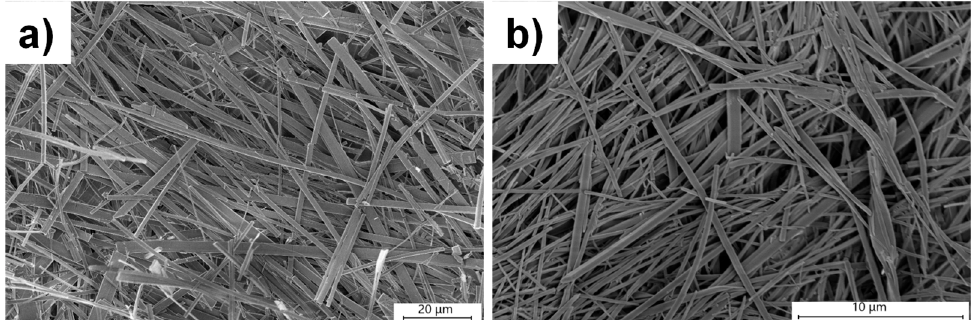
Figure 10. SEM images of xerogels obtained with L 3 in the presence of 1.0 equivalence of CdCl 2 in ( a ) 0.7 wt% in pure water and ( b ) 2.0 wt/v% in DMSO/water (1:1, v / v ). We analyzed the powder X-ray patterns of the dried gels at 2.0 wt% and 0.7 wt% of L 3 hydrogels in the presence of 1.0 equivalence of CdCl 2 , respectively. Analysis of the PXRD pattern revealed a different PXRD pattern for mixed L 3 -CdCl 2 xerogels compared to the L 3 xerogel at 2.0 wt% (Figure S13) in both cases. This may be attributed to the complex- ation of L 3 with CdCl 2 , resulting in the formation of a stable hydrogel at a lower ligand concentration (0.7 wt%) induced by metal-ligand-driven supramolecular self-assembly. PXRD pattern of the mixed L 3 -CdCl 2 xerogels at 2.0 wt/v% of L 3 obtained from an aqueous mixture (1:1, v / v ) of methanol, ethanol, DMF, and DMSO did not match with the